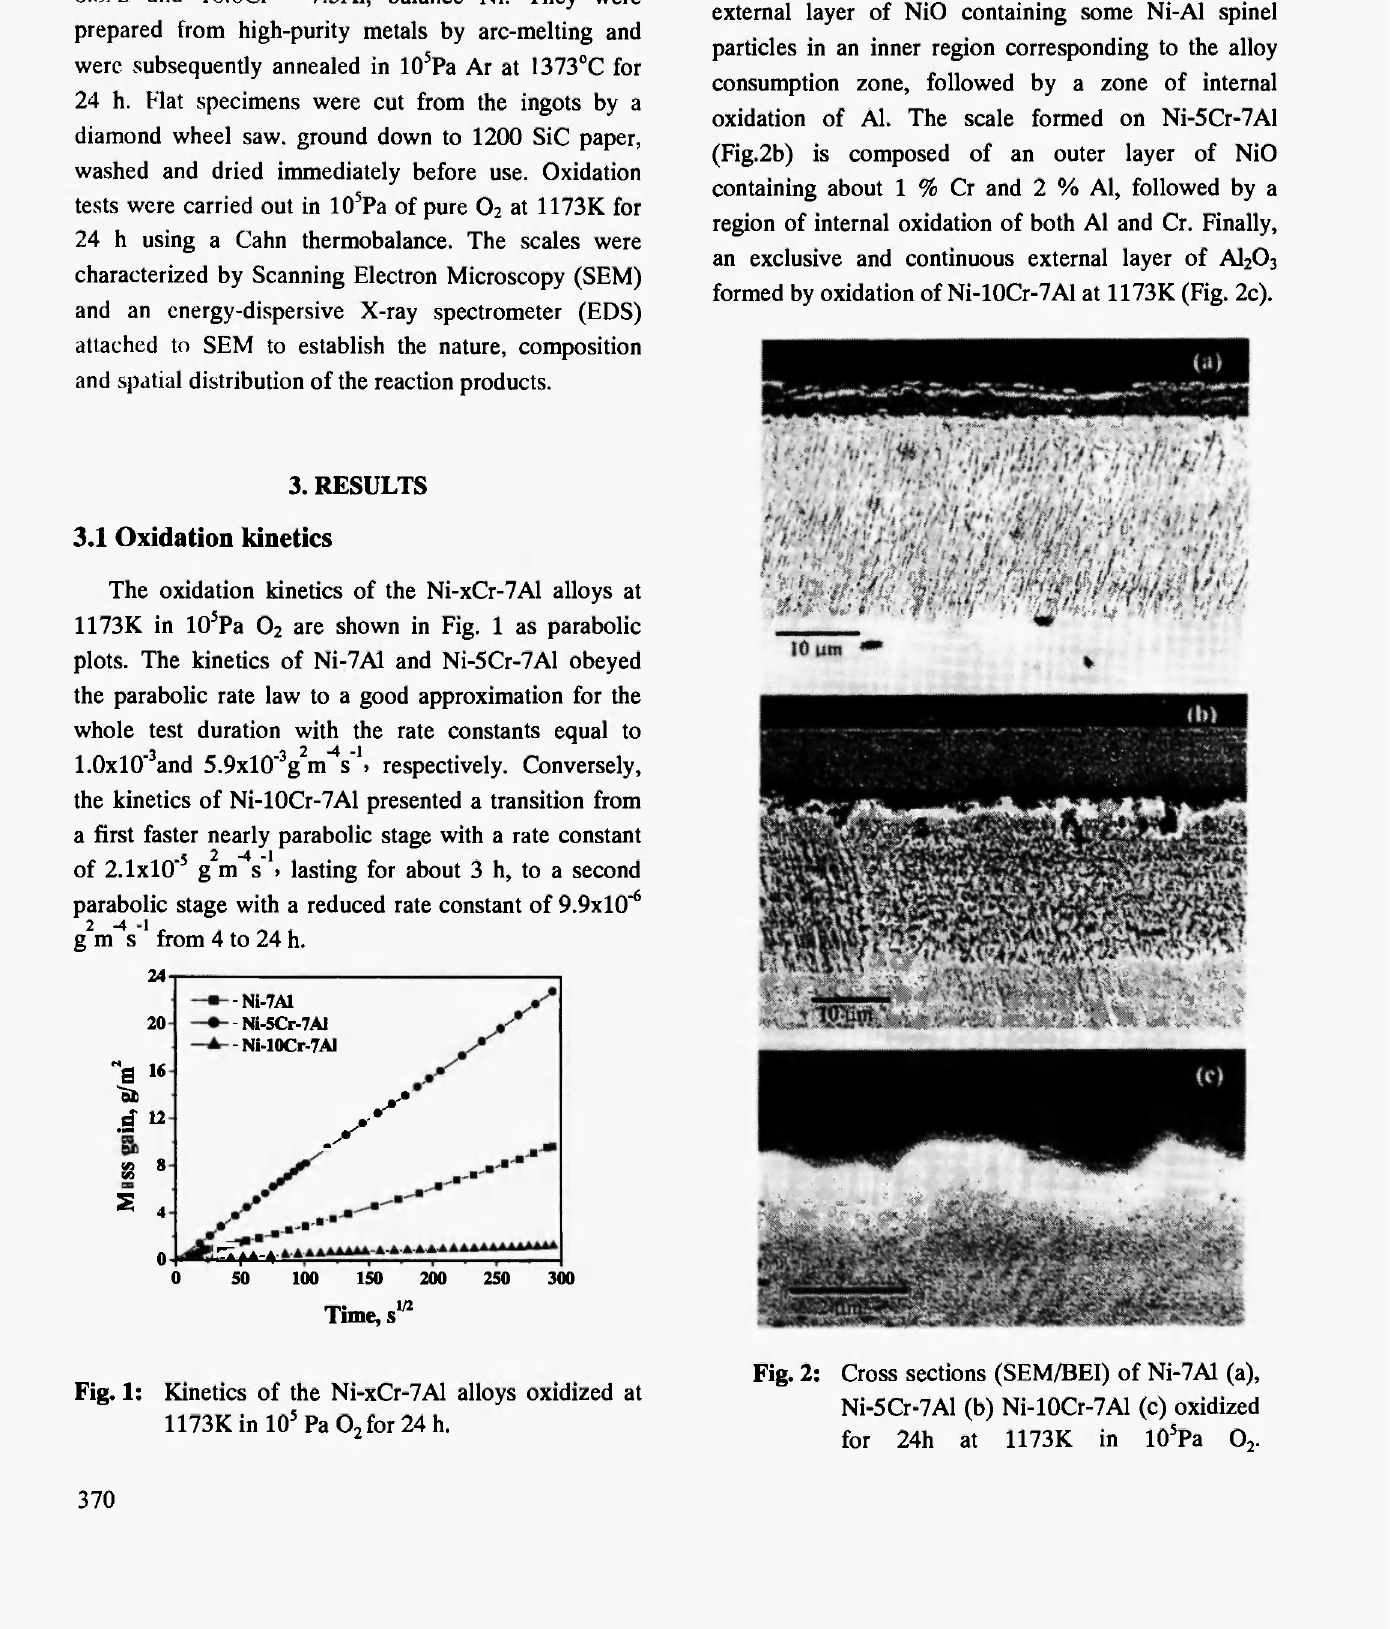
Fig. 1: Kinetics of the Ni-xCr-7Al alloys oxidized at 1173K in 10 5 Pa0 2 for24h.